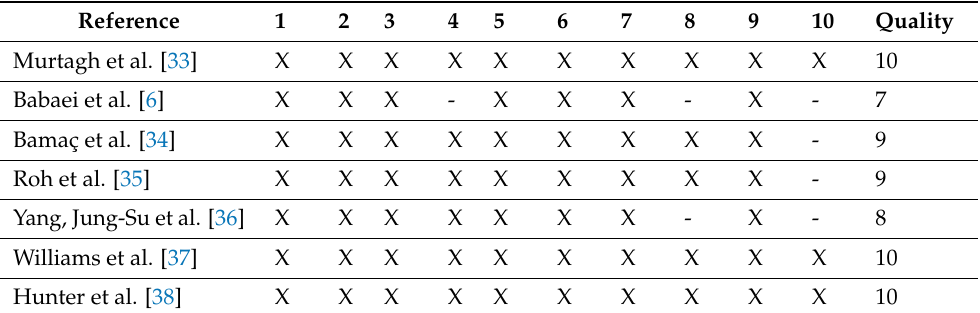
Table 2. Methodological assessment of the included